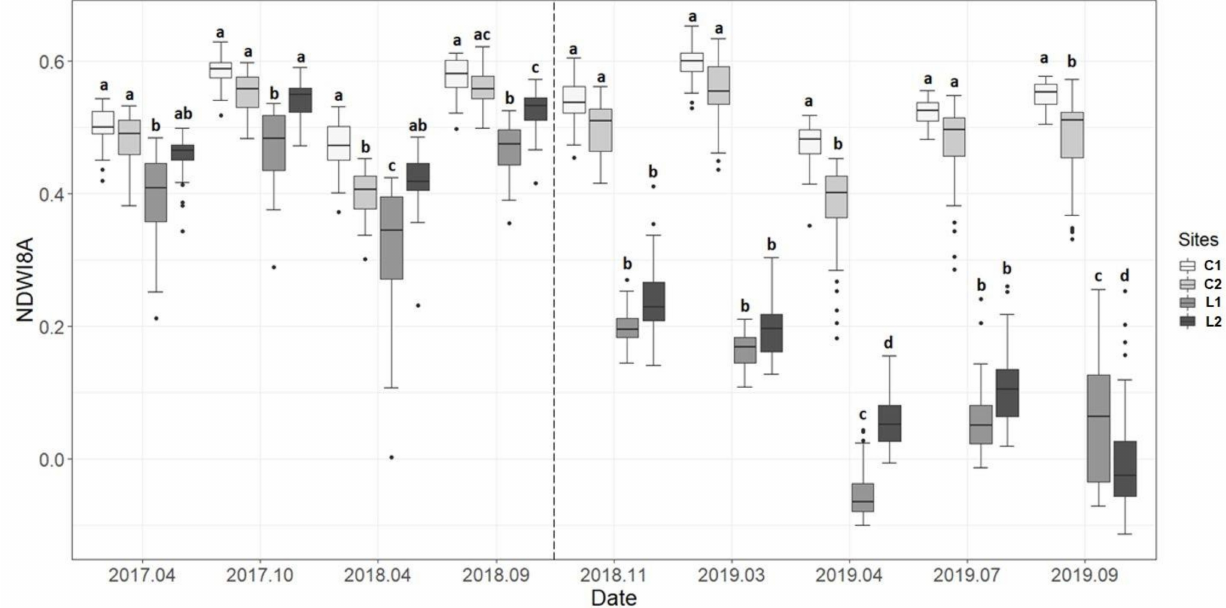
Figure 2. Median values, 25th and 75th percentiles of Normalized Difference Water Index with a narrow near-infrared band (NDWI8A) temporal profiles for control (C1 and C2) and study sites (L1, L2) for each of the dates reported in Table 1. Letters denote statistical significance between control and wind-damaged sites index values ( p -value < 0.05). The dash line separates pre and post-Vaia